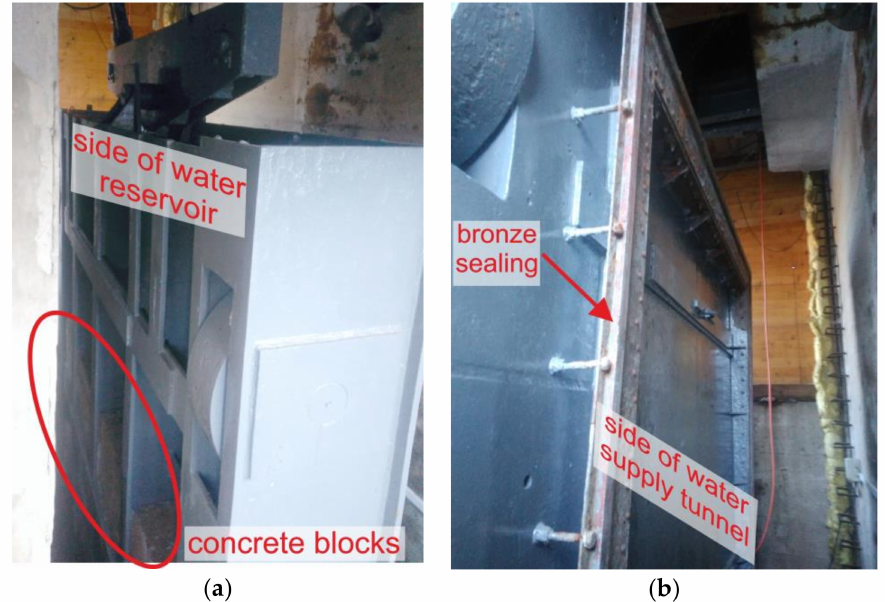
Figure 2. View of the sluice gate: ( a ) from the side of the water reservoir and ( b ) from the side of the water